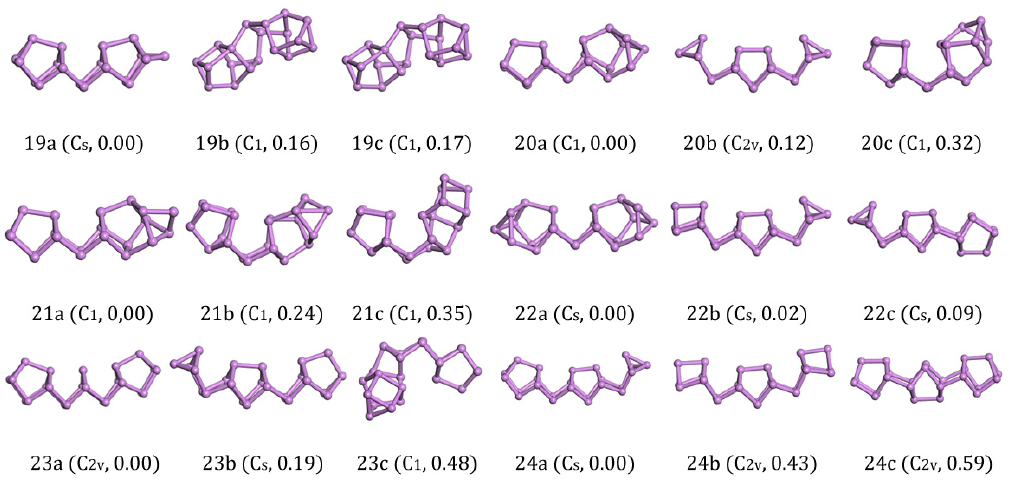
Figure 3. Lowest-energy and isomorphic structures for As n ( n = 19–24) clusters. The relative total energies are in eV.